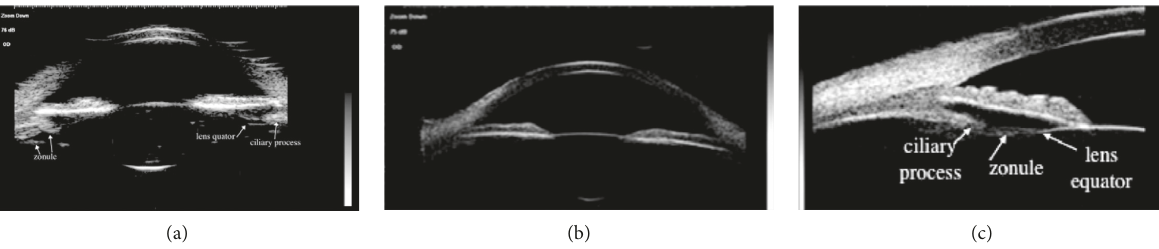
Figure 1: The lens position images of normal subjects obtained in the same patient with 25 and 50MHz UBM. (a) The normal subject image of 25MHz UBM in the axial section, from left to right, the ciliary process, lens equator, and zonule were marked by arrows; (b) the normal subject image of 50MHz UBM in the axial section; (c) the normal subject image of 50 MHz UBM in the longitudinal section, the ciliary process, zonule, and lens equator were marked by the arrows from left to right.